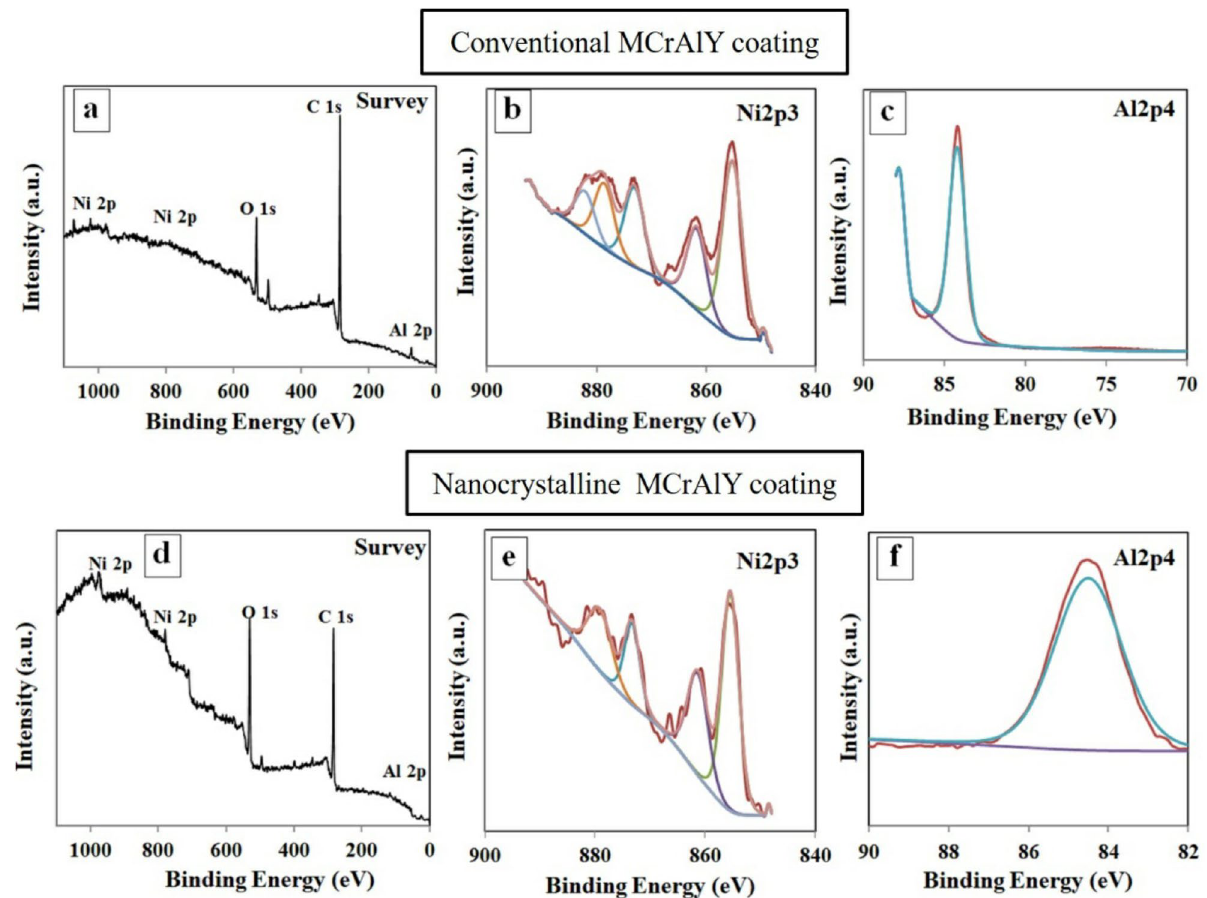
Figure 14. XPS results of the oxidized surface of the conventional and nanocrystalline coating: ( a , d ) survey peaks, ( b , e ) Ni 2p peaks, ( c , f ) Al 2p